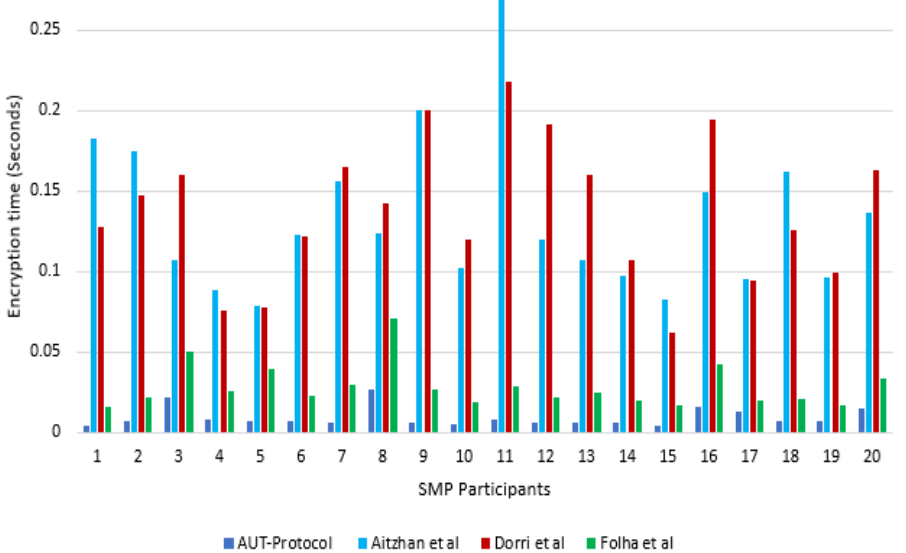
Figure 4. Comparison of the transactional message encryption times.